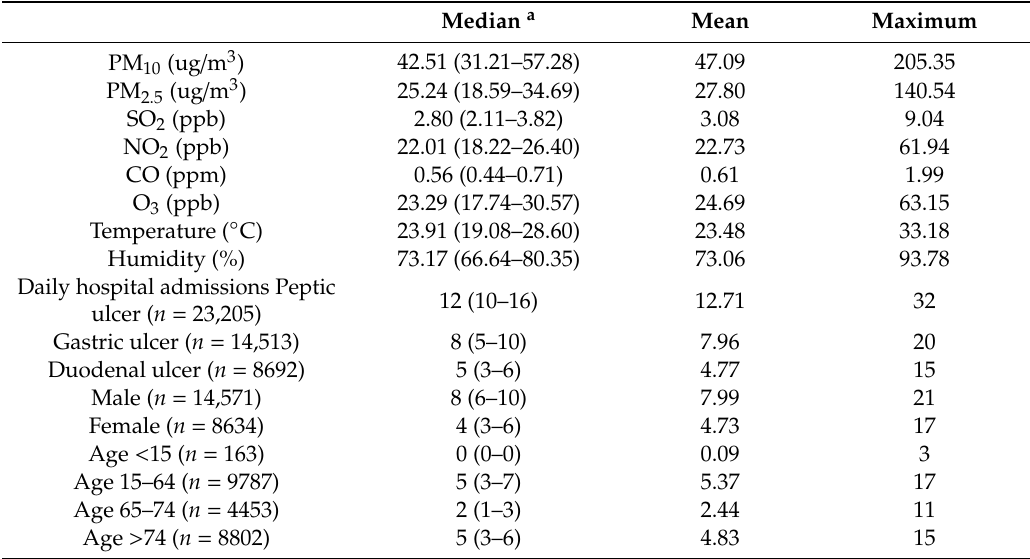
Table 1. Distribution of daily peptic ulcer admissions, weather, and air pollutant concentrations in Taipei, Taiwan, 2009–2013.